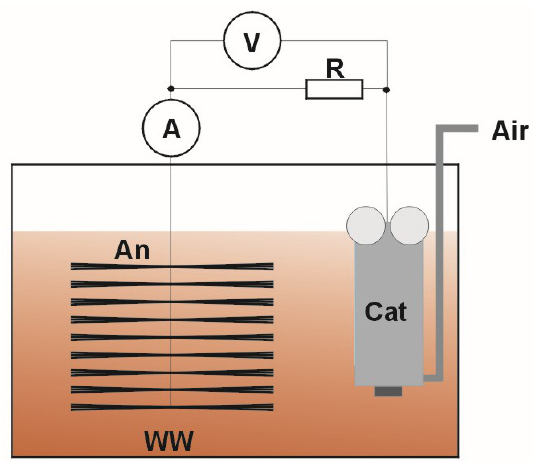
Figure 2. Diagram of microbial fuel cell (MFC) applied in the measurements. A: ammeter, V: voltmeter, R: load, An: anode, Cat: Ni–Co cathode in HIPS housing, WW: wastewater from a wastewater treatment plant in a yeast factory, Air: air